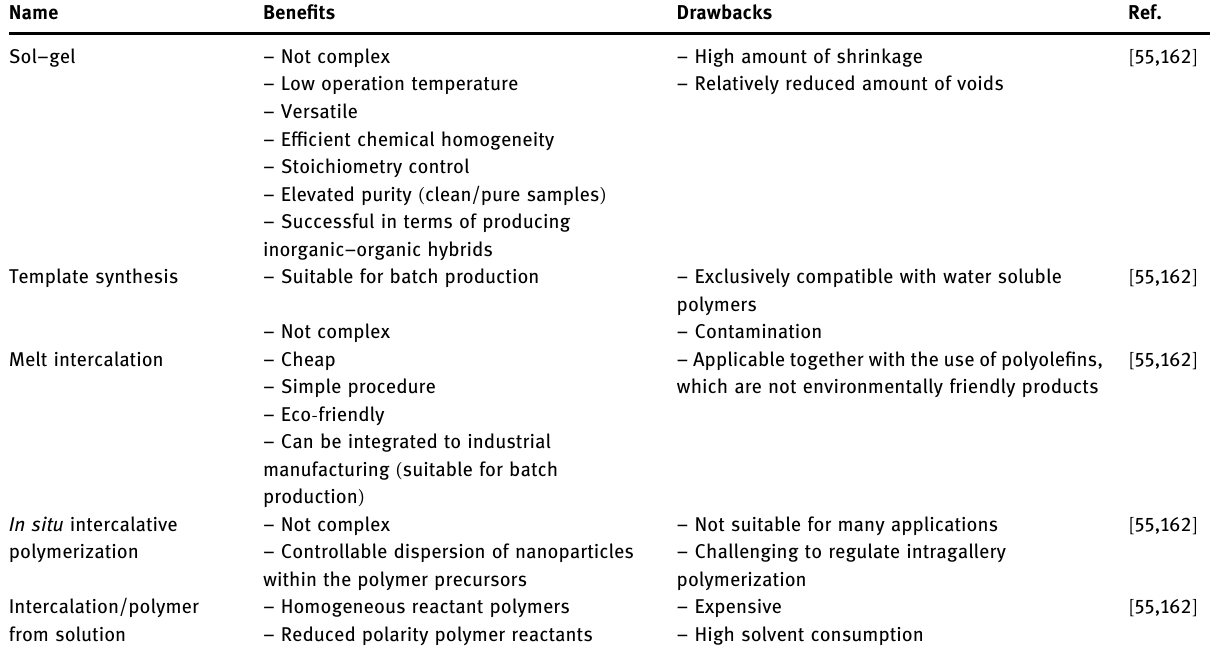
Table 17: The advantages and disadvantages of PMNC processing